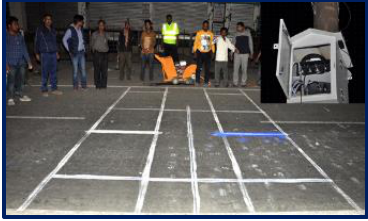
Figure 7. Installation of Loops under Road Pavement